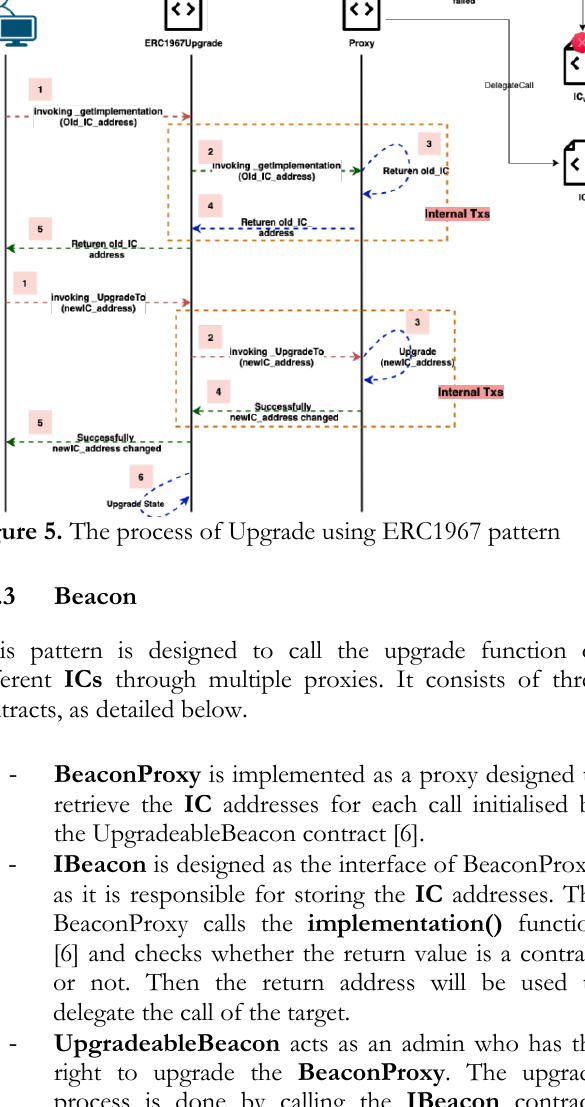
Figure 7. Process of interaction with the Beacon